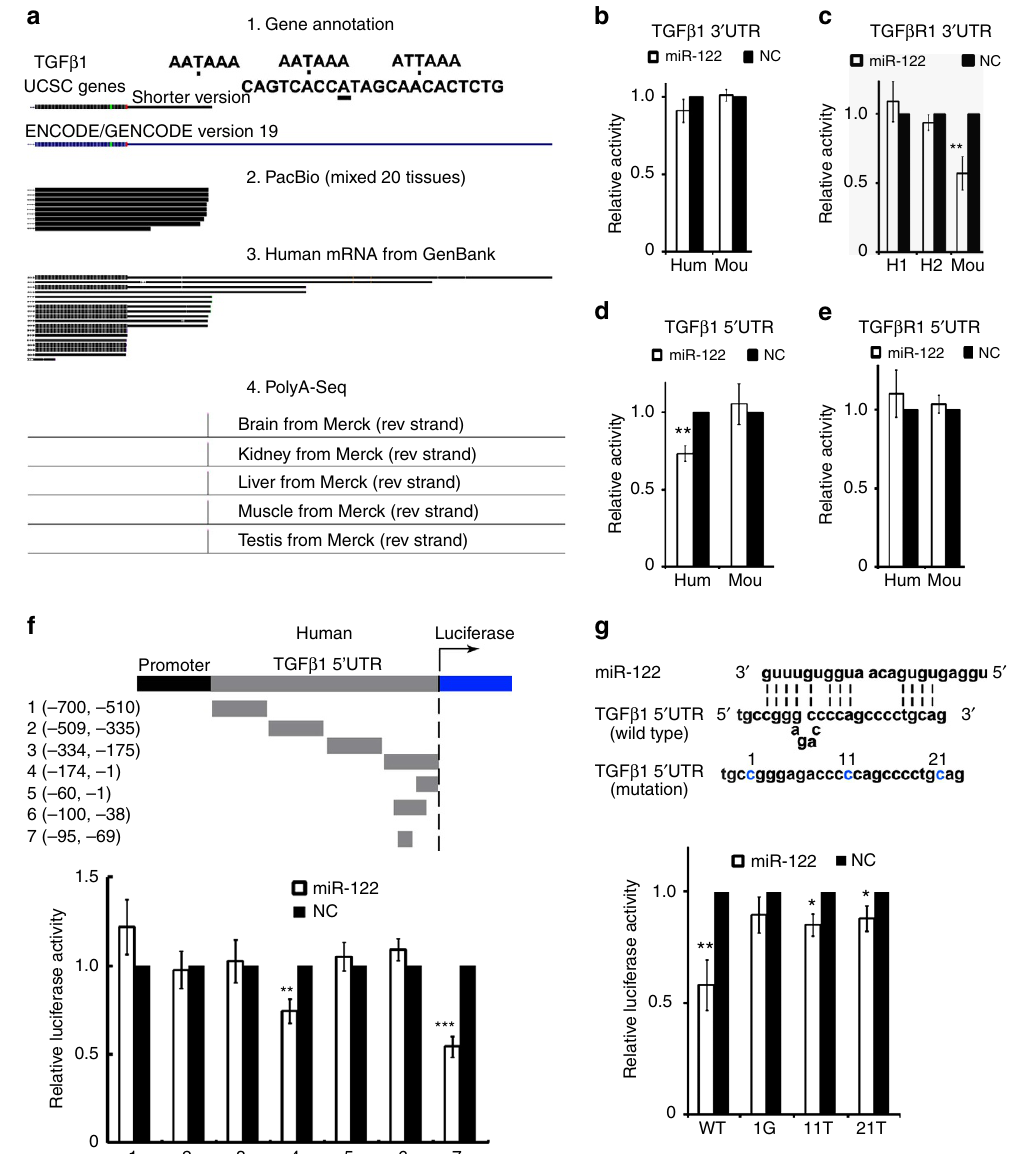
Figure 2 | miR-122 targets human TGF b 1 5 0 UTR in a non-‘seed-region’ base-pairing manner. ( a ) Evidence for the different versions of human TGF b 1 mRNA, which include gene annotation from UCSC Genes and ENCODE/GENCODE, the PacBio sequencing data from mixed 20 tissues 24 , human mRNA from GenBank (NCBI) or PolyA sequencing data of different tissues 25 . ( b – e ) Luciferase activity was measured after transfection of the indicated reporter constructs in Hela cells. TGF b R1 5 0 UTR was cloned into the promoter region. Hum, human, Mou, mouse. The TGF b 1 3 0 UTRs were cloned into the 3 0 UTR of luciferase in a pGL plasmid. The 3 0 UTR of human TGF b 1 was divided into two parts, H1 or H2, because of its long length. Six independent repeats are performed in each experiment. ( f ) Luciferase activity was measured after transfection of the indicated reporter constructs. The human TGF b 1 5 0 UTR was divided into three different fragments and then each truncated 5 0 UTR was cloned into the promoter region of pGL plasmid. Six independent repeats are performed in each experiment. ( g ) Diagram depicting the miR-122 targeting region of the TGF b 1 5 0 UTR and the mutated site. Luciferase reporter activity containing the different constructs was shown below. Error bars, ± s.d. * P o 0.05; ** P o 0.01; *** P o 0.001 by two-sided Student’s t